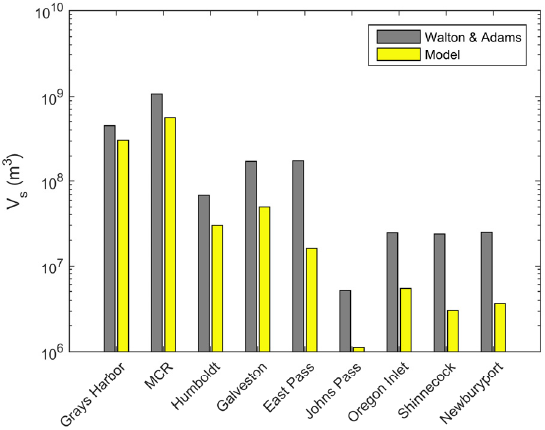
Figure 12. Shoal volume at the end of the simulation derived from the model and the empirical formula of Walton and Adams.